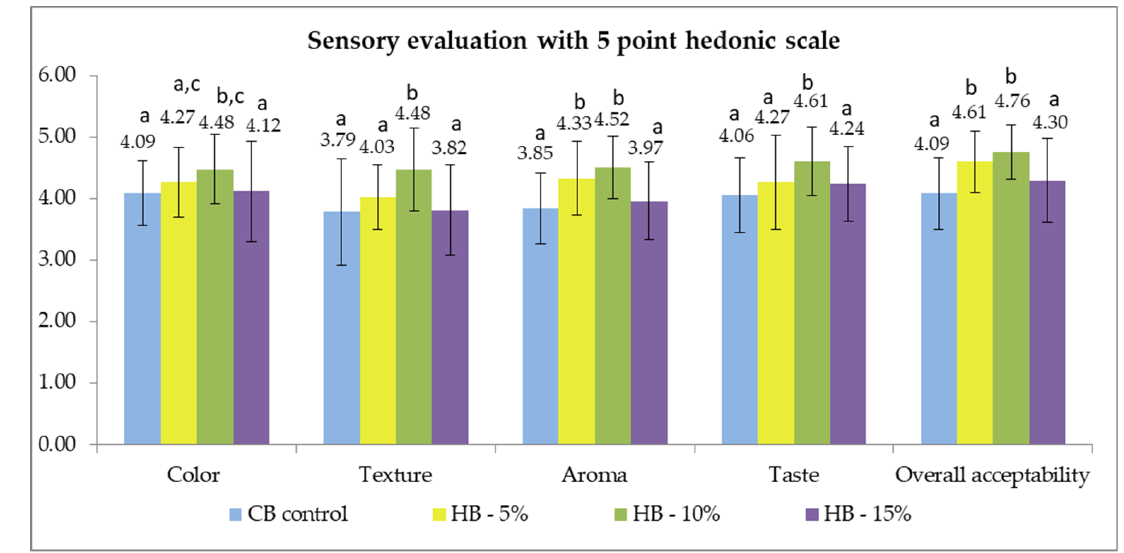
Figure 6. Global values of the sensory evaluation (consumer acceptance) of studied biscuits (CB—control, HB—5%, HB—10%, HB—15%) by using 5-point hedonic scale (n = 33). Different letters (a–c) among samples for the same sensory attributes indicate significant differences ( p < 0.05) among values according to the t-test.